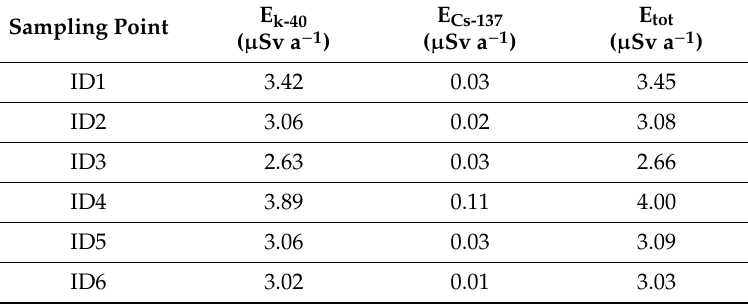
Table 3. The 40 K, 137 Cs and total e ff ective dose due to sample ingestion by adult members of the